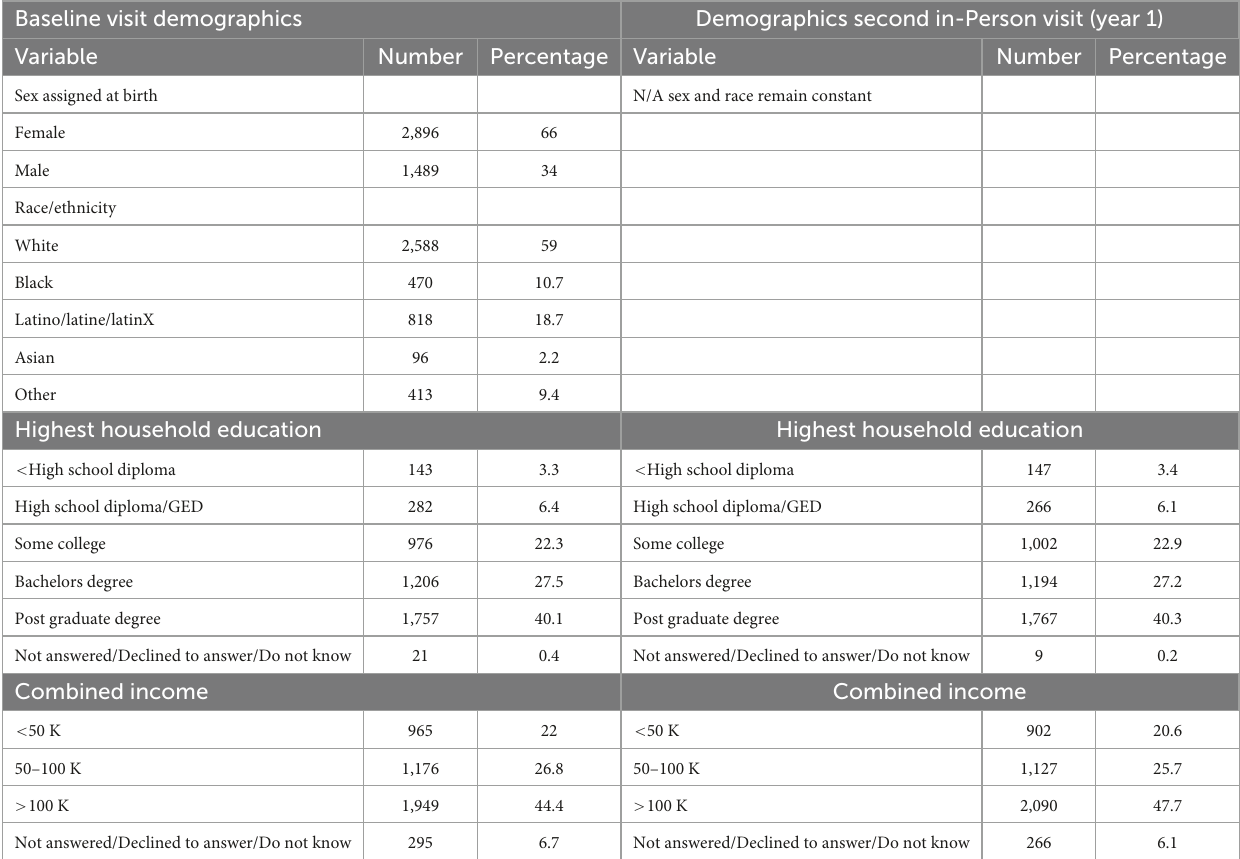
TABLE 4 Demographics of participants used in